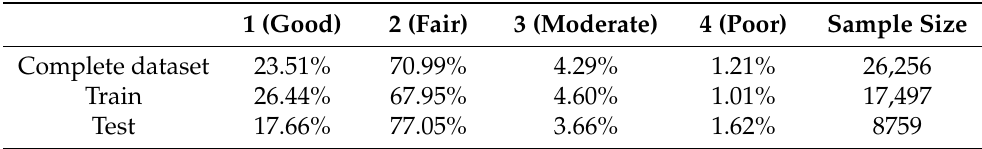
Table 3. Relative frequency (%) of each category of the class variable (NAQI) and sample sizes for the complete, train, and test